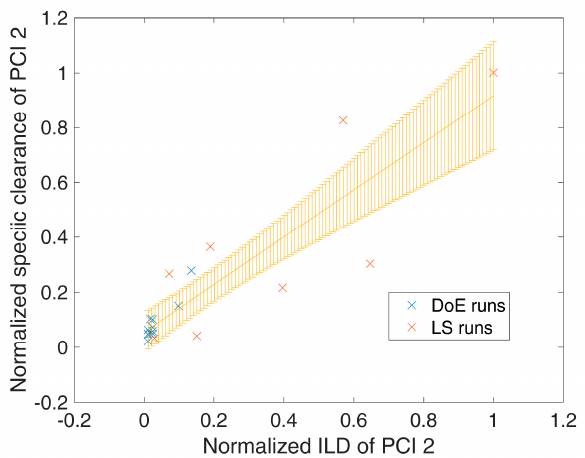
Figure 1. Exemplary plot for dependency of specific clearance (here of process-related impurity 2) against impurity loading density of process-related impurity 2 of DoE runs (blue) and large scale (LS) runs (red). Yellow error bars indicate the mean model prediction error. Normalization has been performed by division of the maximal value for each axis.